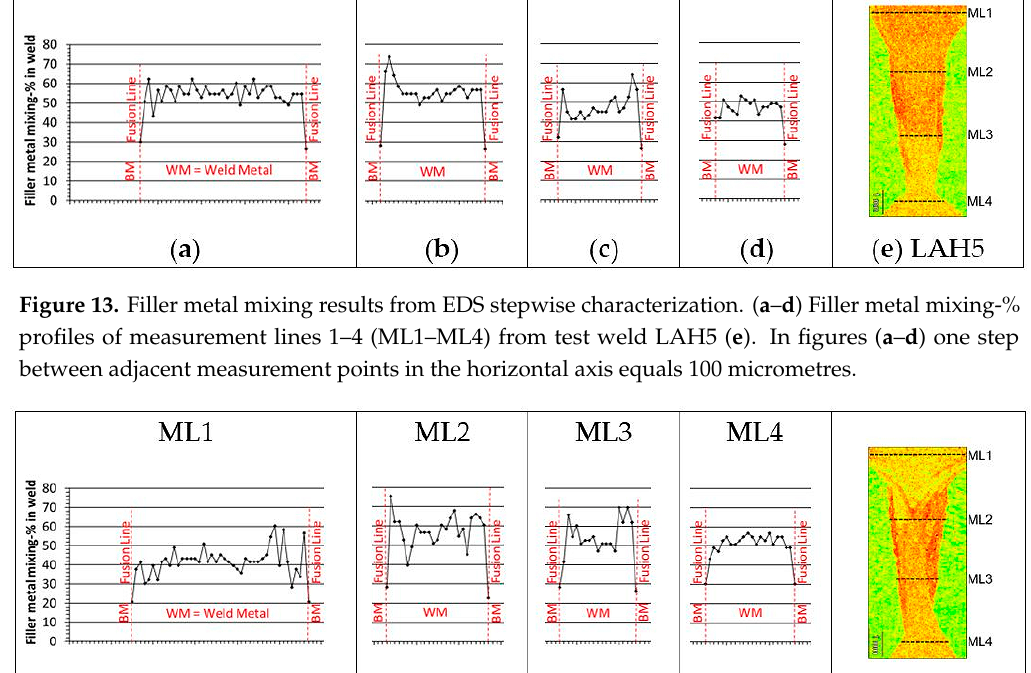
13 Figure 12. Filler metal mixing results from EDS stepwise characterization. ( a – d ) Filler metal mixing- % profiles of measurement lines 1–4 (ML1–ML4) from test weld LAH4 ( e ). In figures ( a – d ) one step between adjacent measurement points in the horizontal axis equals 100 micrometres. When laser-arc hybrid welds were produced in single-pass V-groove configuration, average filler metal mixing values of measurement lines ML1 to ML4 had the highest mixing values of the laser-arc hybrid test welds. From Figure 10, it can be seen that in weld LAH5, which was made using leading wire feeding, the average filler metal mixing values are ~46% at the bottom part of the groove area (ML3 and ML4) and ~54% at the surface part (ML1 and ML2). The test weld LAH6, which was made using trailing wire feeding, shows ~56% average mixing level values at one third thickness of the joint (ML2) and when measuring deeper in the joint at ML3 and ML4, average values were ~53% and 50%, respectively. When examining Figure 9(e) and particularly Figure 9(f), it can be noticed that chromium as regards weight-% is not homogenously distributed in the mid-section area of both weld LAH5 and LAH6. Red and orange colours indicating high chromium weight-% levels can be clearly seen near the fusion lines at the mid-thickness range of both welds. The filler metal mixing profiles